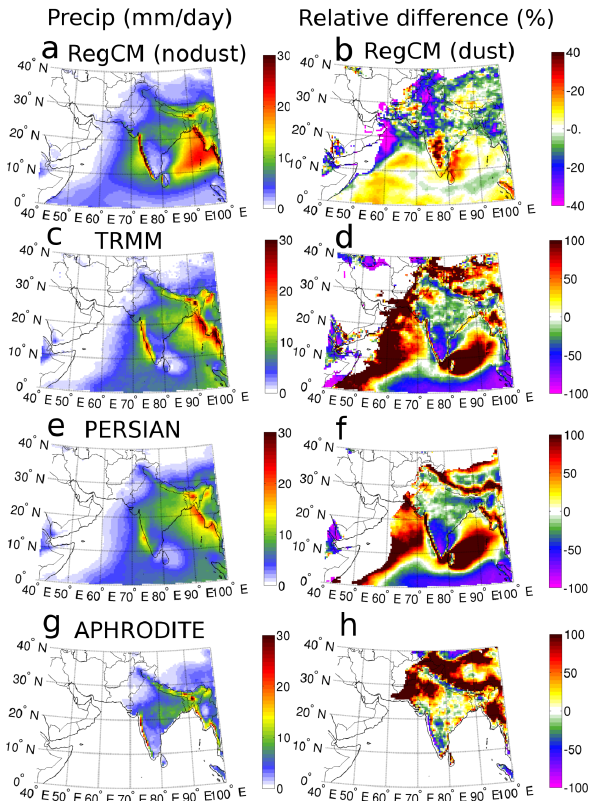
Figure 6. (a) Mean JJAS 2000–2009 precipitation simulated by the model in “ nodust ” configurations. (b) Relative difference in precipitation between dust and nodust simulations for JJAS 2000– 2009 and calculated as ( dust − nodust / nodust ) × 100. (c) JJAS 2000–2009 TRMM precipitation. (d) Relative difference (bias) be- tween nodust and TRMM precipitations for observed precipitation level > 0.2mmday − 1 . (e – f) Same than (c – d) for the PERSIANN data set. (g – h) Same than (c – d) for the APHRODITE data sets but calculated for JJAS 2000–2007 only. All modeling results represent a three-ensemble-member mean.